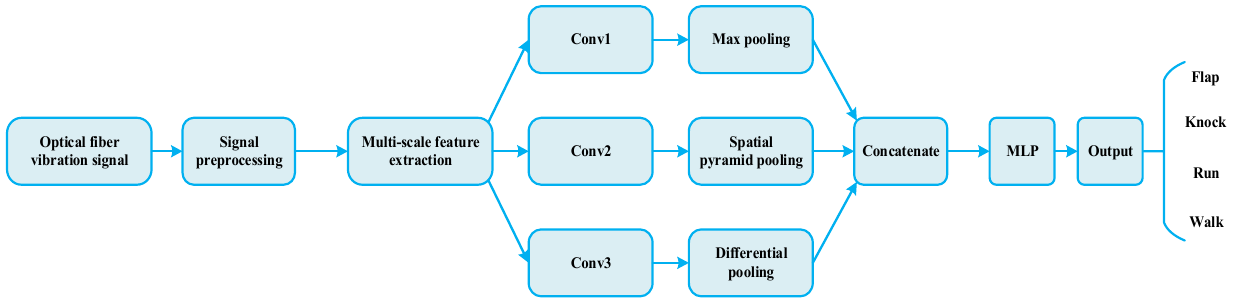
Figure 2. The overall structure of optical fiber vibration signal recognition based on fusion of multi − scale features.